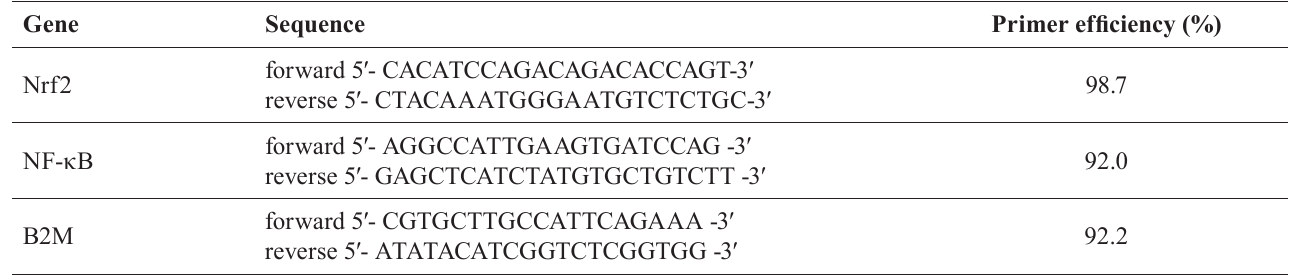
TABLE I - P rimer sequences